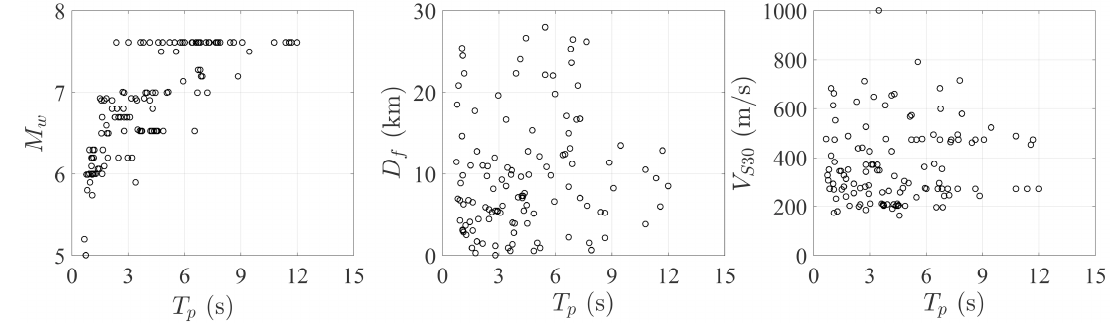
Figure 2. Variability of moment magnitude M w , closest site-to-source distance D f and soil preferred shear-velocities V S 30 as function of the pulse period T p within the considered dataset.